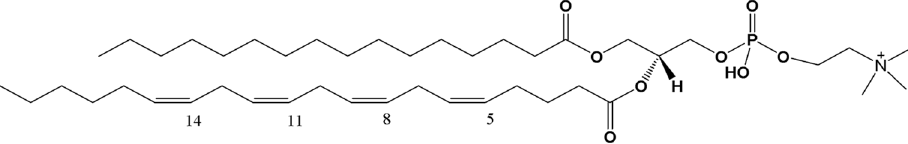
Figure 1. Structure of 1-palmitoyl-2-arachidonoyl-sn-glycero-3-phosphocholine (PAPC). The polyunsaturated fatty acyl chain on the sn -2 position of PAPC is the target for non-enzymatic and enzymatic oxidation. Non-enzymatic oxidation is initiated by free radicals or non-radical reactive oxygen species (ROS). Free radicals include OH radical, OOH radical, NO radical, NO 2 radical, and superoxide anion radical. Sources of free rad- icals are air pollution, smoking, UV-light, radiation, and several enzymes (e.g., NADPH oxidase and xanthine oxidase). Examples of non-radical ROS included singlet oxygen and ozone [6–8]. Enzymes including 12/15 lipoxygenases and cytochrome c were capable of 11].